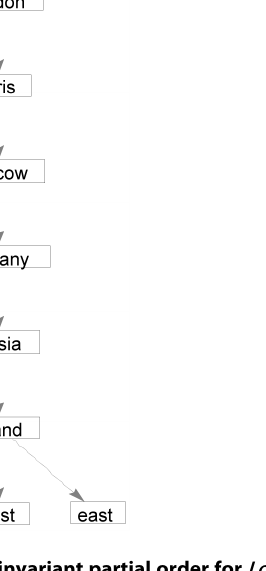
Figure 7. Joint invariant partial order for London relative to the set of words { London, Moscow, Paris, north, south, east, west, Germany, Poland, Russia }. Brain data derived from FIGURE 1 and semantic data from the WordNet data in Figure 2.